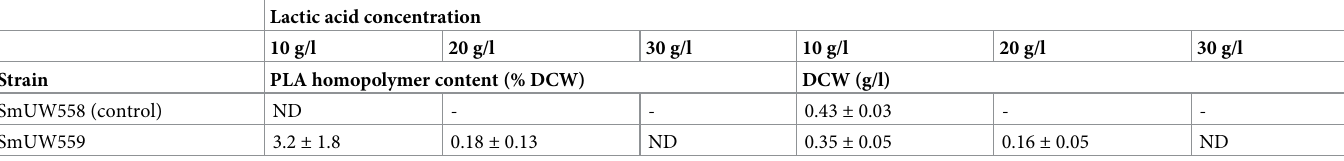
Table 2. PLA homopolymer production in S . meliloti phbAB phbC mutant background harbouring pTAM. Lactic acid concentration 10 g/l 20 g/l 30 g/l 10 g/l 20 g/l 30 g/l Strain PLA homopolymer content (% DCW) DCW (g/l) SmUW558 (control) ND - - 0.43 ± 0.03 - - SmUW559 3.2 ± 1.8 0.18 ± 0.13 ND 0.35 ± 0.05 0.16 ± 0.05